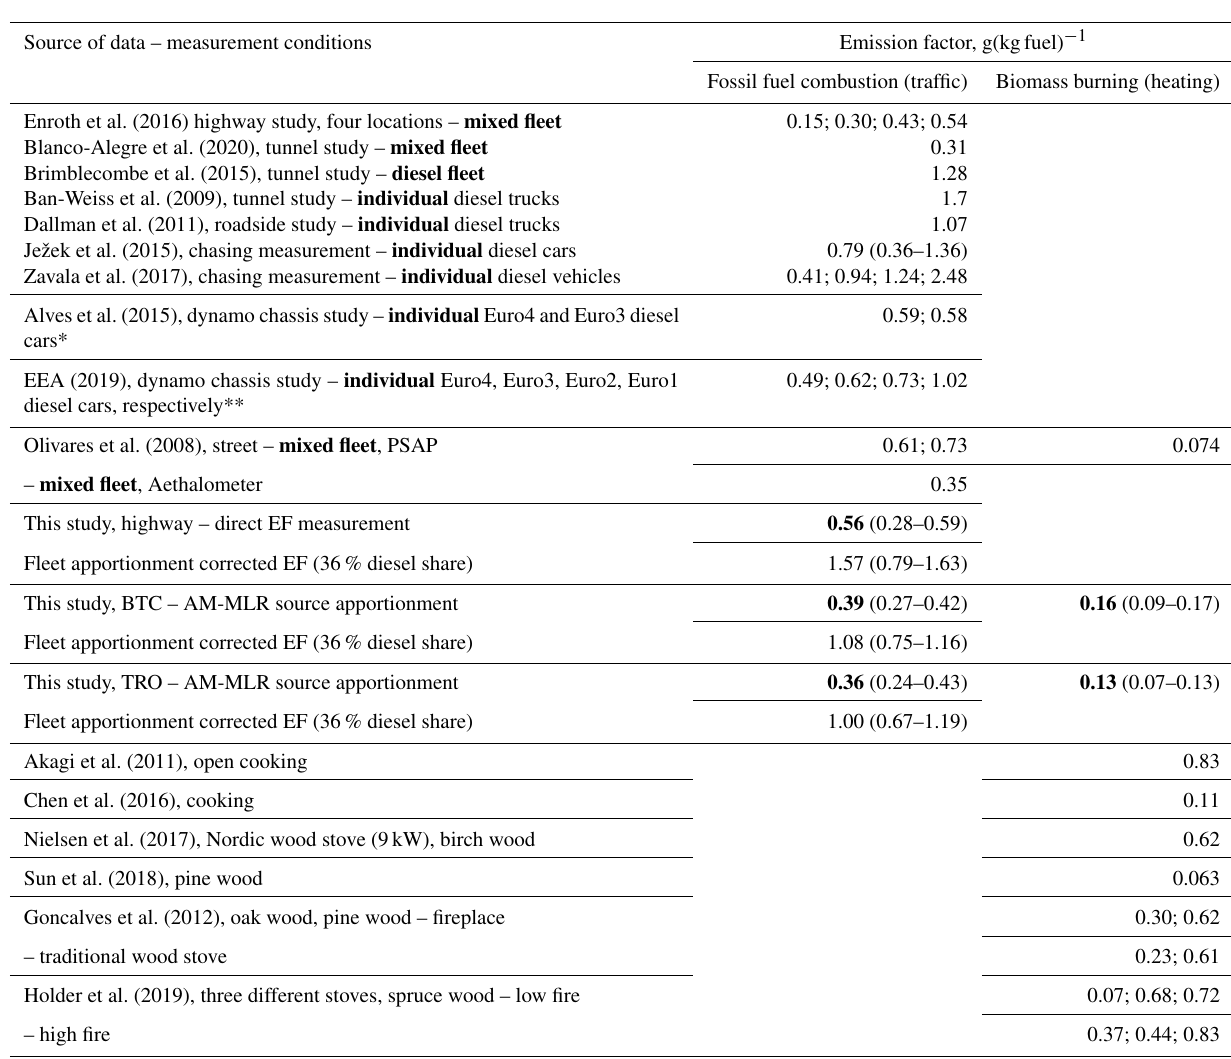
Table 6. Emission factors of fossil fuel and biomass burning sources. Comparison of the results of this study with the literature. Results from the present study are shown as mean values and the interquartile range in brackets (q1–q3). Source of data – measurement